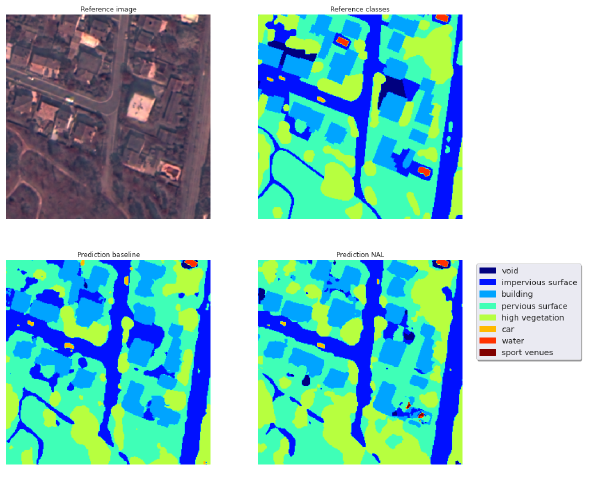
Figure 11. Visual